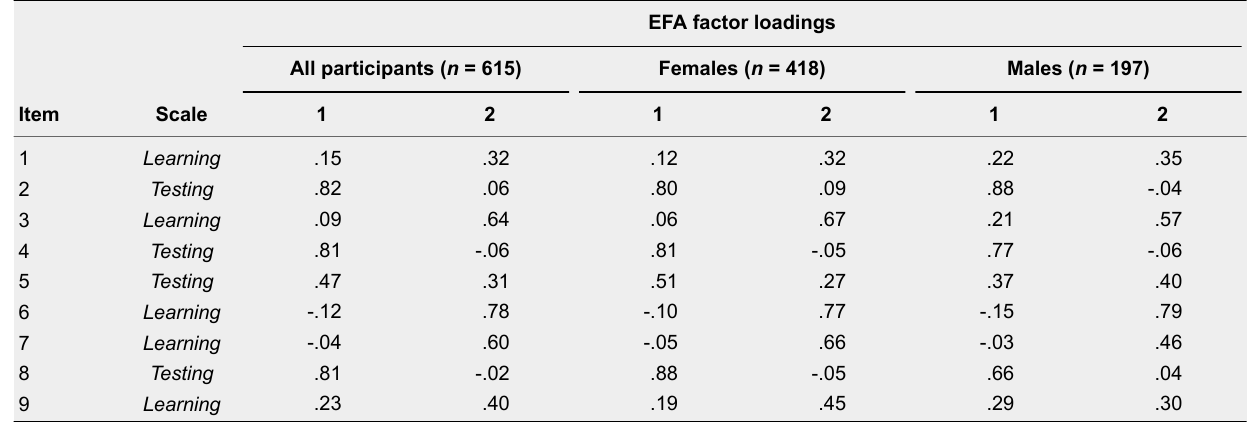
Factor Loadings of AMAS Items Estimated by Means of Exploratory Factor Analysis (Simple OBLIMIN